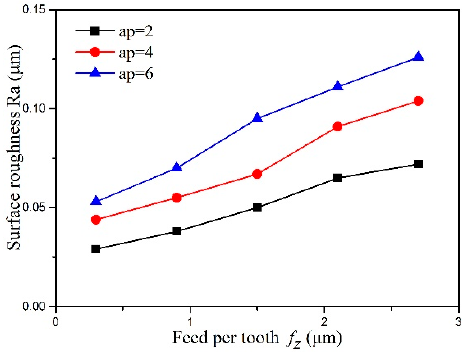
Figure 9. The effect of machining parameters on surface roughness.